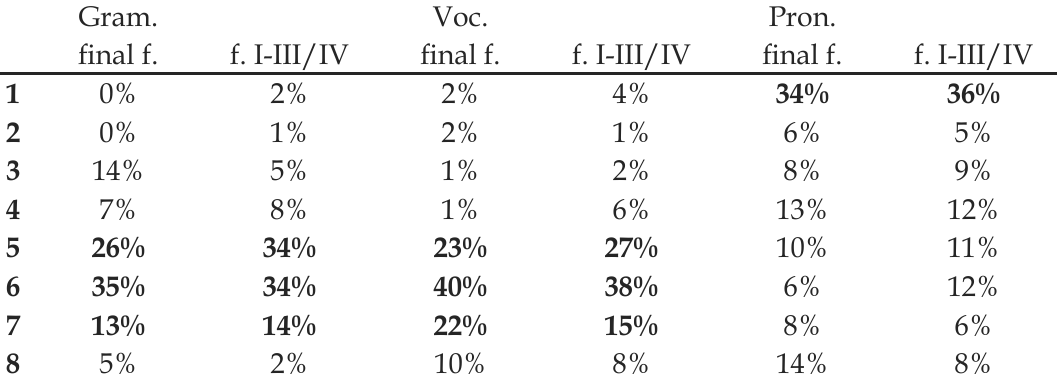
Frequency of summative assessment provision in the case FL subskills Gram. Voc. Pron. (cid:192) nal